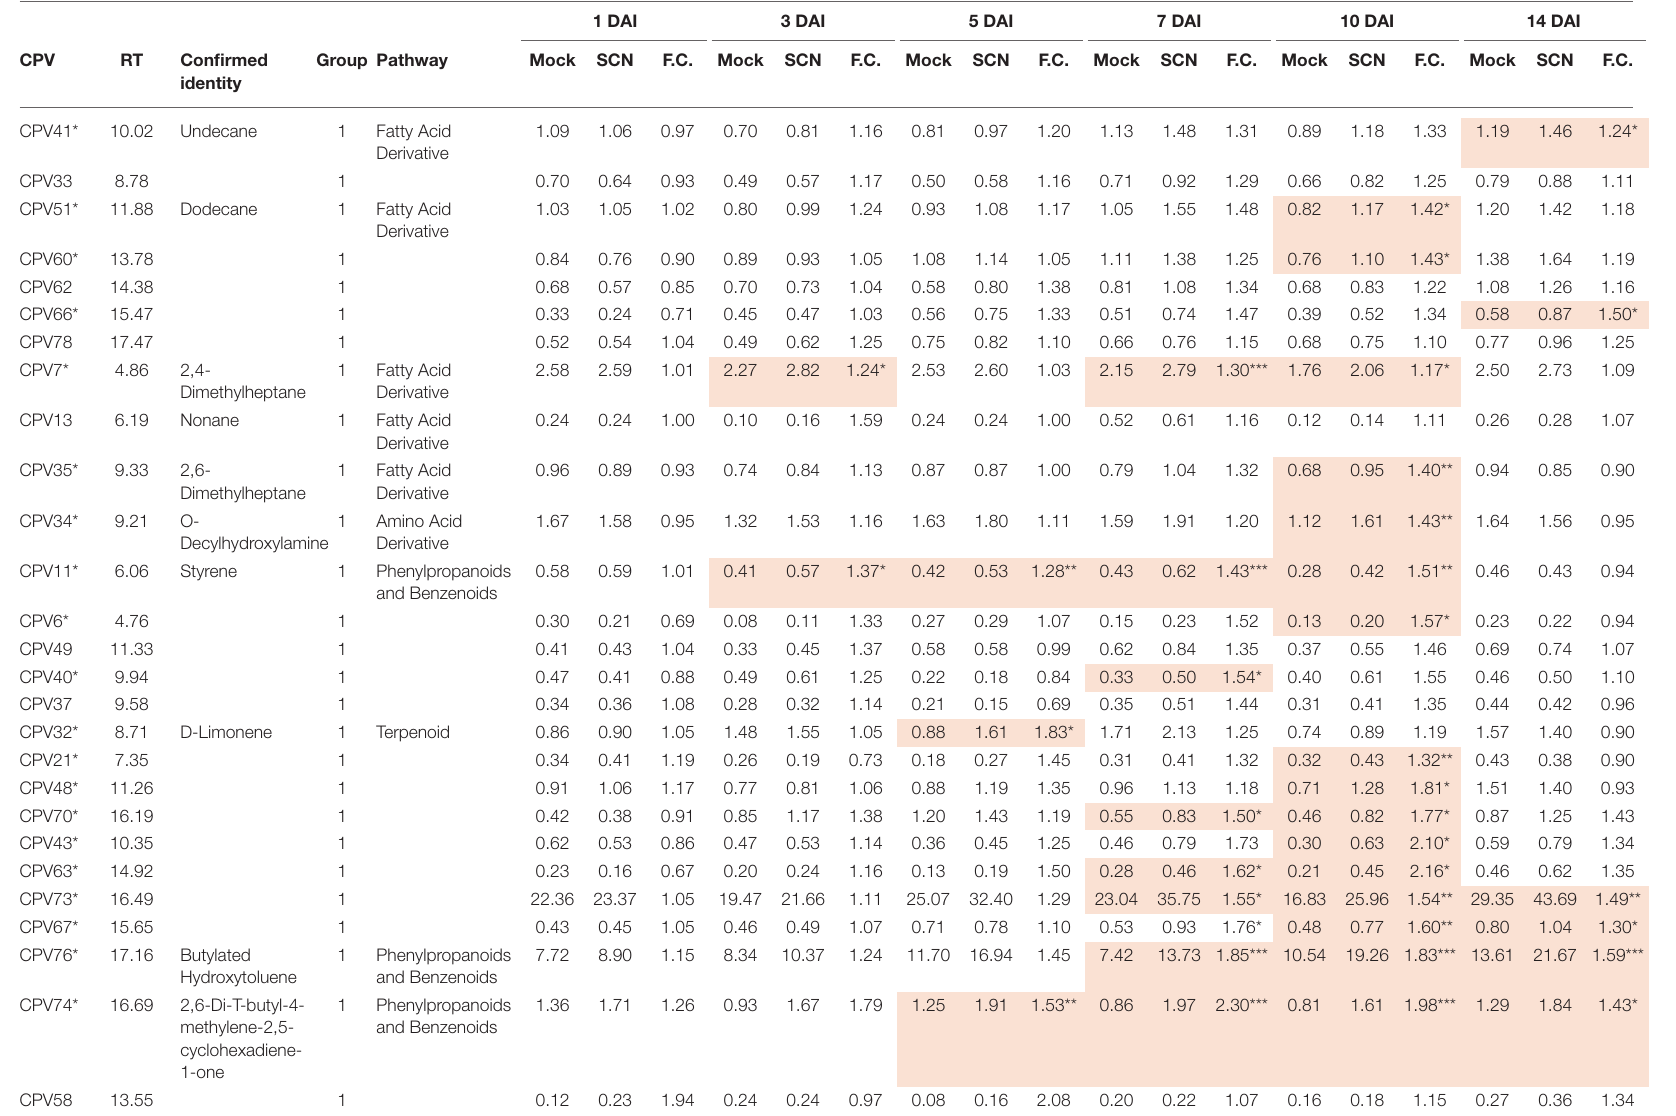
TABLE 1 | Properties of the 107 Common Plant VOCs